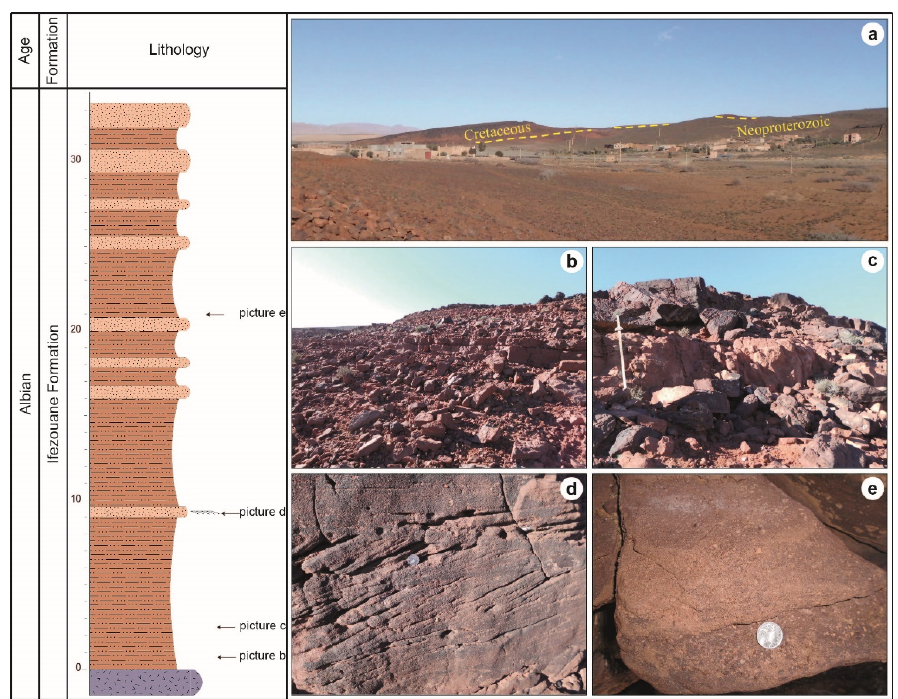
Figure 12. Anounizme section. ( a ) geological unconformity between the Neoproterozoic basement and the Cretaceous series; ( b – c ) sandstone beds interspersed with sandy siltstone intervals; ( d ) sand ‐ stone bed with oblique stratification; ( e ) sandstone with some channelized microconglomer ‐ ate including Neoproterozoic elements.